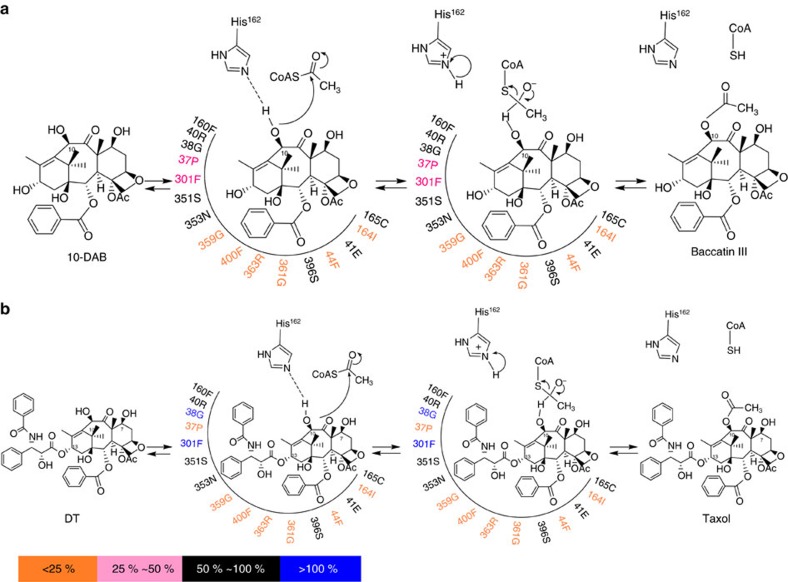
The putative catalytic processing of 10-DAB or DT by DBAT supported by DBAT activity assays after site-specific mutagenesis.In the catalytic process, His162 of DBAT acts as a general base catalyst and deprotonates the substrate 10-DAB or DT. (a) For 10-DAB, Gly359, Phe400, Arg363, Gly361, Phe44 and Ile164 of DBAT seem to form the substrate binding and/or catalytic sites, as supported by the significant decrease in the activity of the enzyme when these residues are mutated to L-alanine. (b) For DT, Pro37, Gly359, Phe400, Arg363, Gly361, Phe44 and Ile164 of DBAT seem to form the substrate binding and/or catalytic sites, due to the significant decrease in the activity after L-alanine scanning mutagenesis. Gly38 and Phe301 do not seem to be involved in substrate binding or be part of the catalytic site, and the G38A and F301A mutations increase the activity of DBAT towards DT.